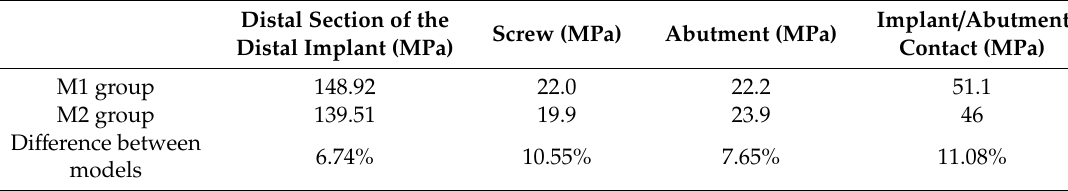
Table 2. von Mises stress measured in each group.